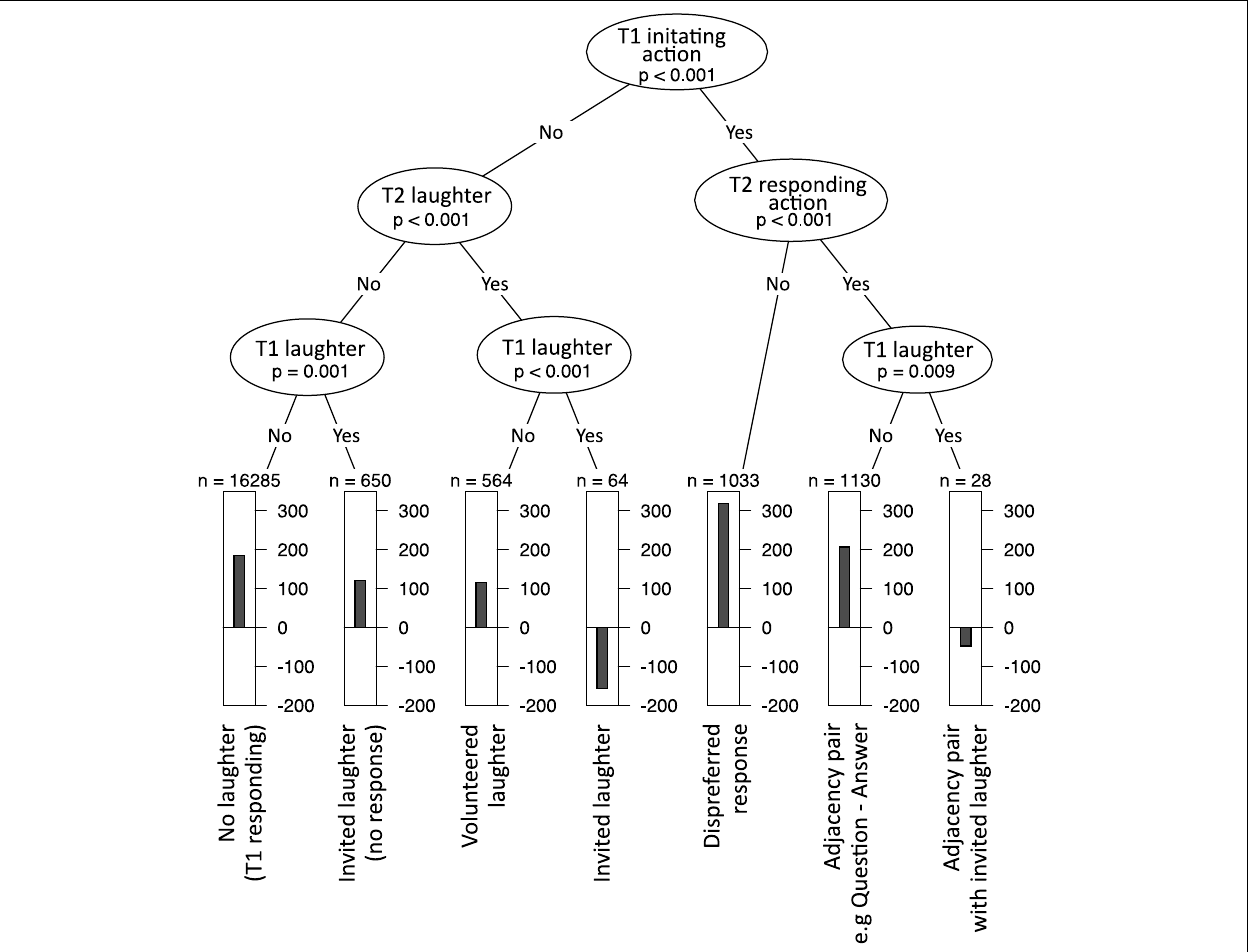
FIGURE 1 | A decision tree splitting FTO data into groups by various measures of sequence